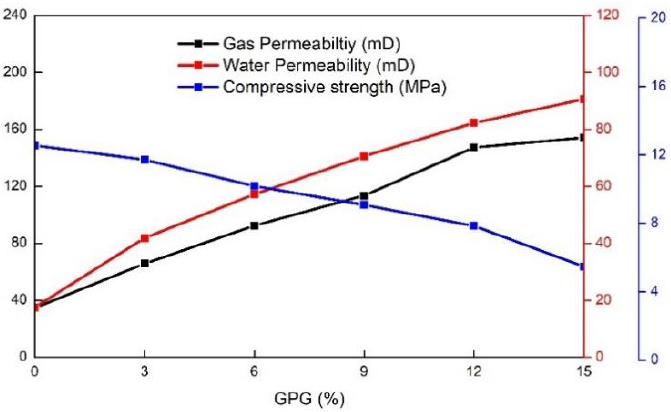
Figure 13. Effect of GPG on the performance of permeable cement stone.